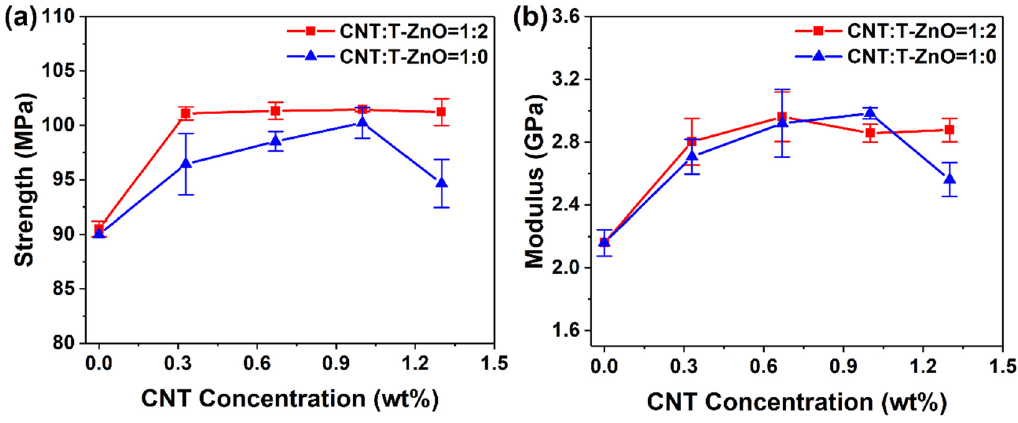
Figure 5: ( a ) Flexural strength and ( b ) fl exural modulus of CNTs/epoxy nanocomposites with and without T